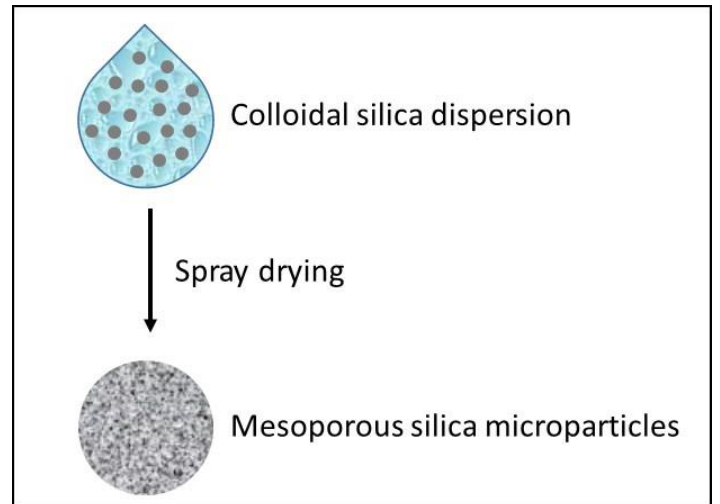
Figure 5. Spray-drying of a colloidal silica dispersion.